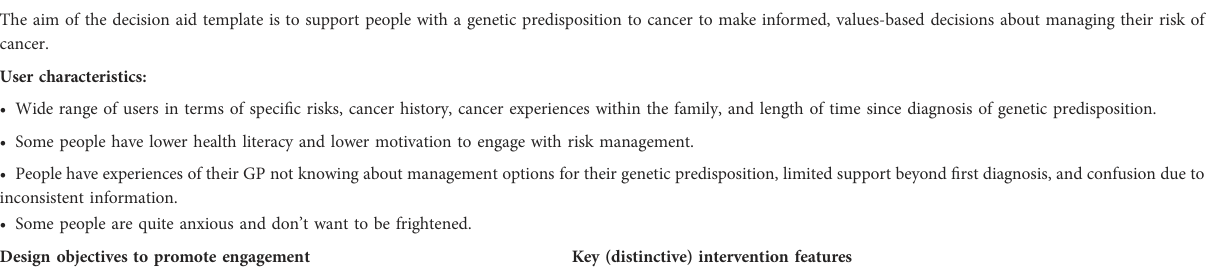
TABLE 5 Guiding principles for engaging target population in decision aid, co-developed with patient panel. Intervention